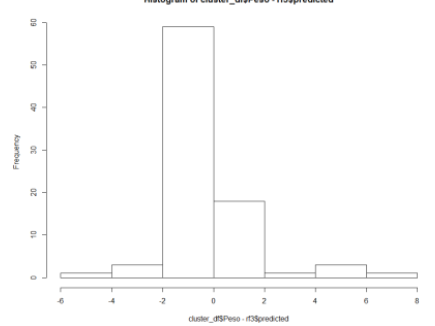
Figure 4. RF IncNodePurity indicates the amount the error increase following the removal of each variable.